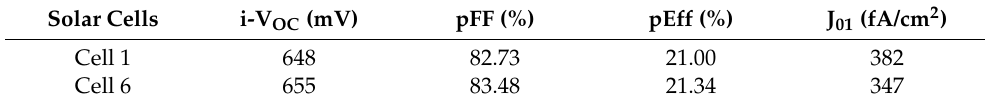
Table 2. The metal recombination, contact resistivity and implied electrical characteristics of the solar cells when use Ag-Al paste and improved firing-through Al paste. Solar